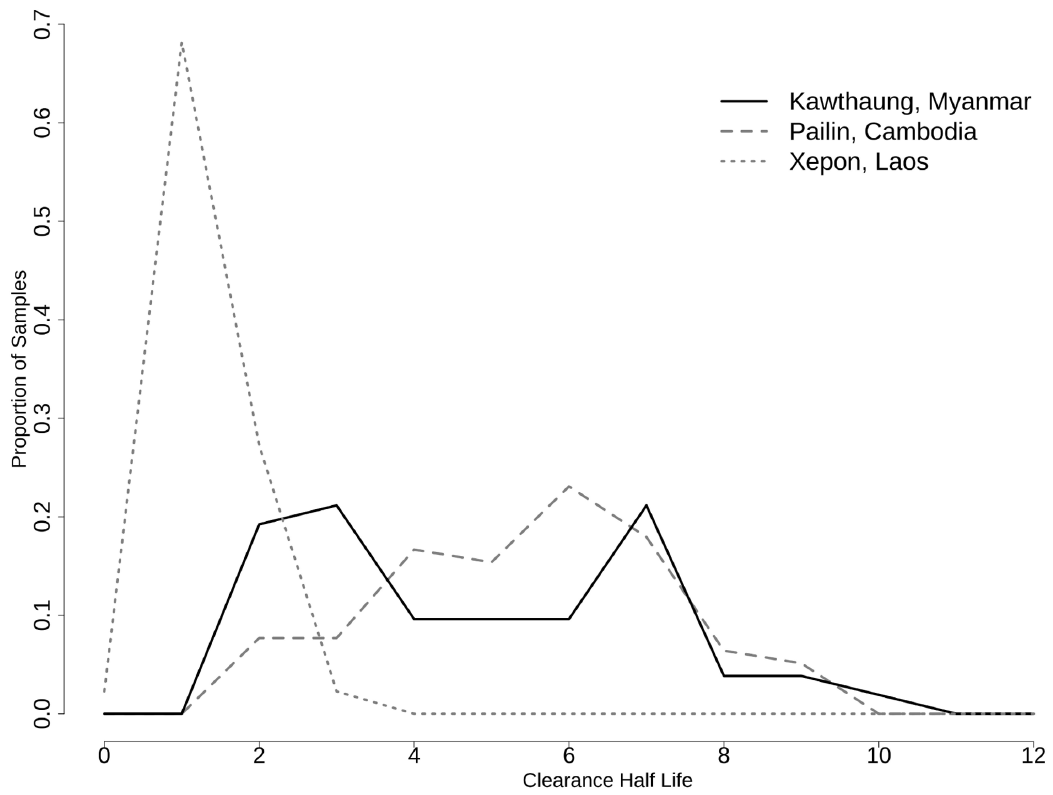
Figure 6. Bimodal distribution of parasite clearance half-life.